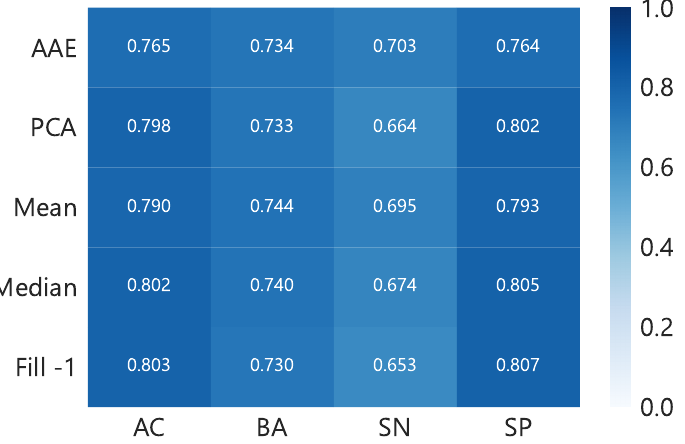
Figure 8. Classification results of 5-folds cross-validation with combined clean and reconstructed noisy data. This resembles the situation when all the modalities are available during learning and inference phases. We notice the AAE network performs better than other technique with high recall rate of 0.703. AC, BA, SN, and SP stand for accuracy, balanced accuracy, sensitivity, and specificity,